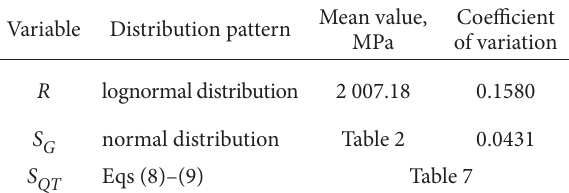
Table 8. Statistical parameters of random